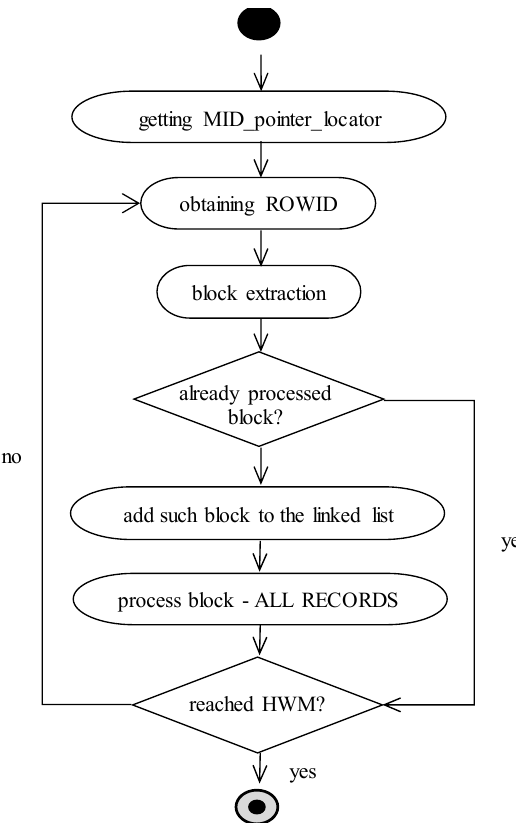
Figure 7. MID_pointer_locator and consecutive data management. MID, master index definition.